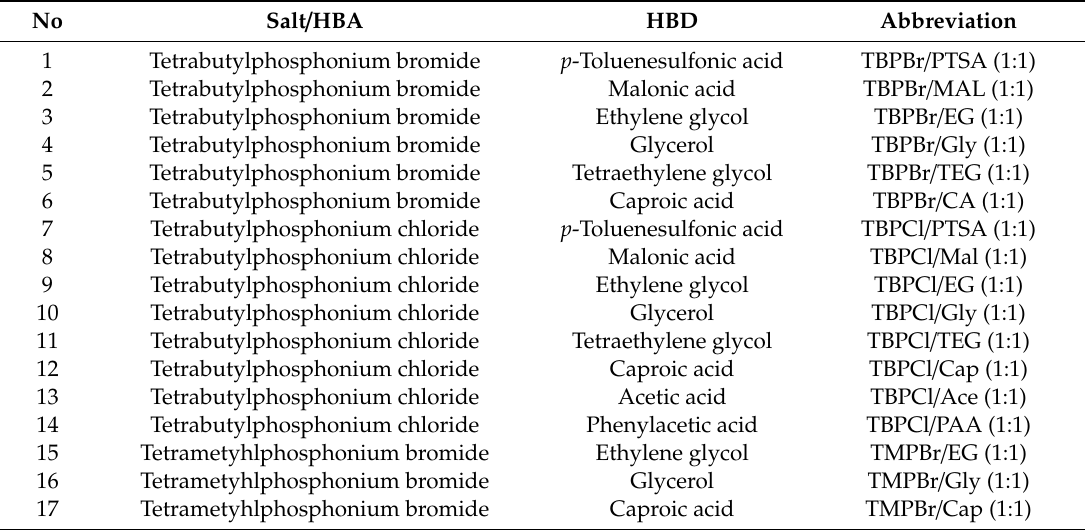
Table 1. List of deep eutectic solvents (DESs) used in COnductor like Screening Model for Real Solvents (COSMO-RS)